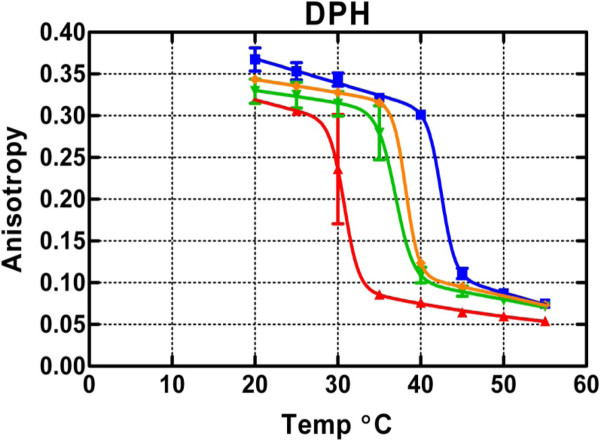
Mean DPH anisotropy in DPPC LUVs measured in 5°C increments from 20-55°C at isoflurane concentrations of 26.3 (red triangles), 15.3 (inverted green triangles), 7.6 (orange diamonds) and 0 mM (blue squares). Data points indicate mean ± 1 SE. Theoretical curves are based on equation 1.